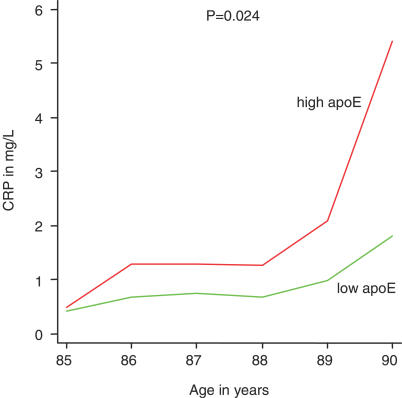
High versus Low Levels of Plasma ApoEHigh (red) and low (green) levels of the protein are depicted. Plasma apoE level was dichotomized on the median, showing that participants with high plasma apoE develop higher CRP levels during follow-up. Estimates of the geometric mean of circulating CRP levels for all years were calculated using a sex-adjusted linear mixed model. The
p-value indicates the statistical significance of additional annual increases of CRP between high and low levels of apoE.